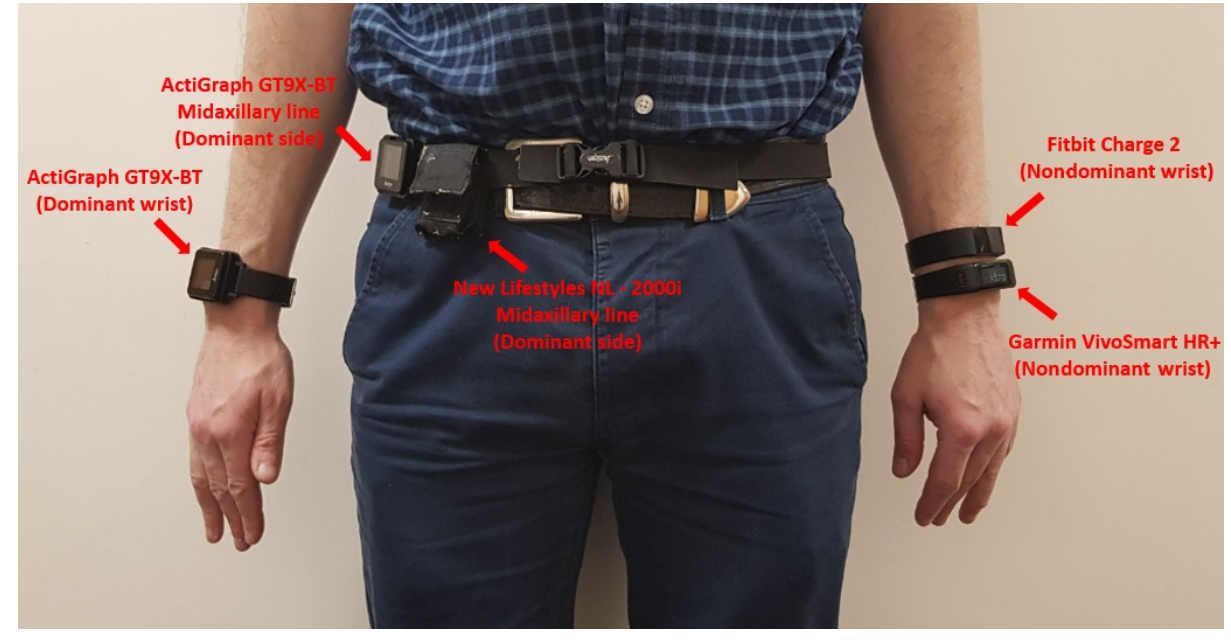
Figure 1. Placement of devices on a